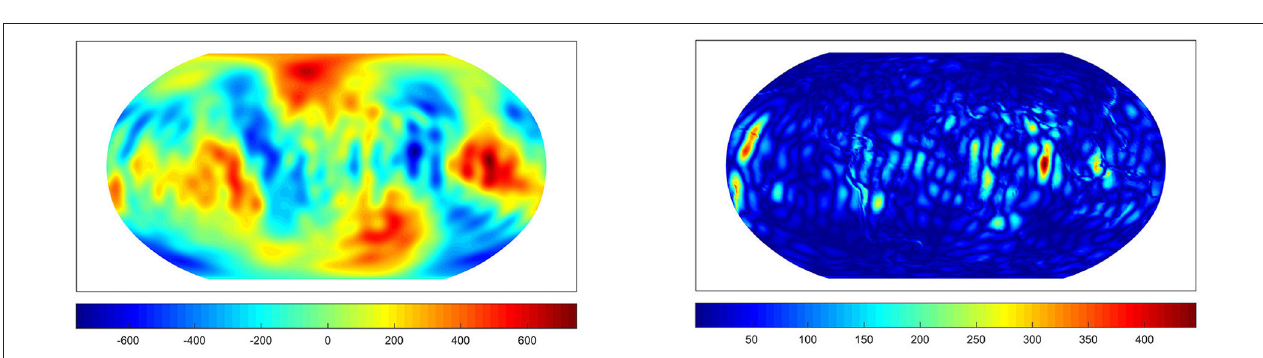
FIGURE 11 | The approximation from the RFMP for the parameter chosen by the GCV (Left) and the difference to the EGM2008 up to degree 100 (Right) . Values in m 2 / s 2 . The inefficiency amounts to 1.16.